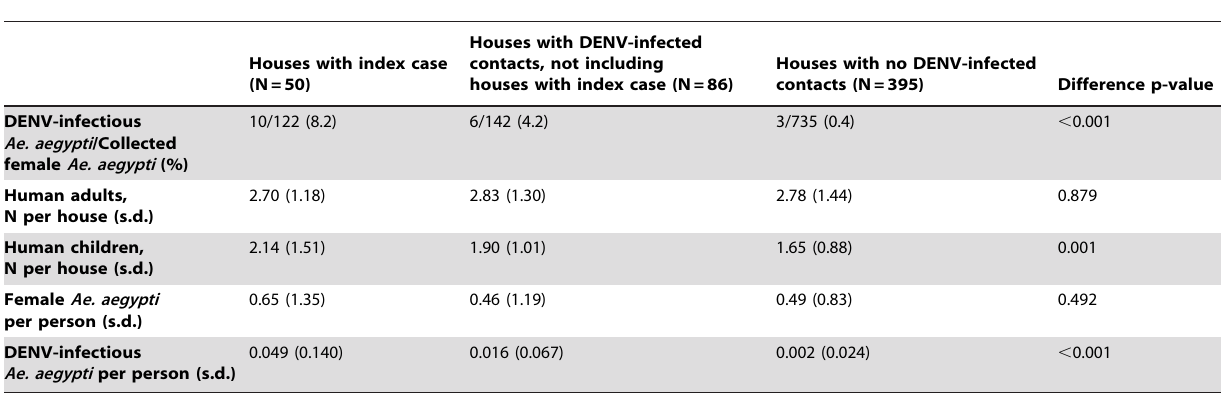
Table 4. Rates of DENV-infectious Ae. aegypti in houses with and without DENV-infected children in positive clusters.